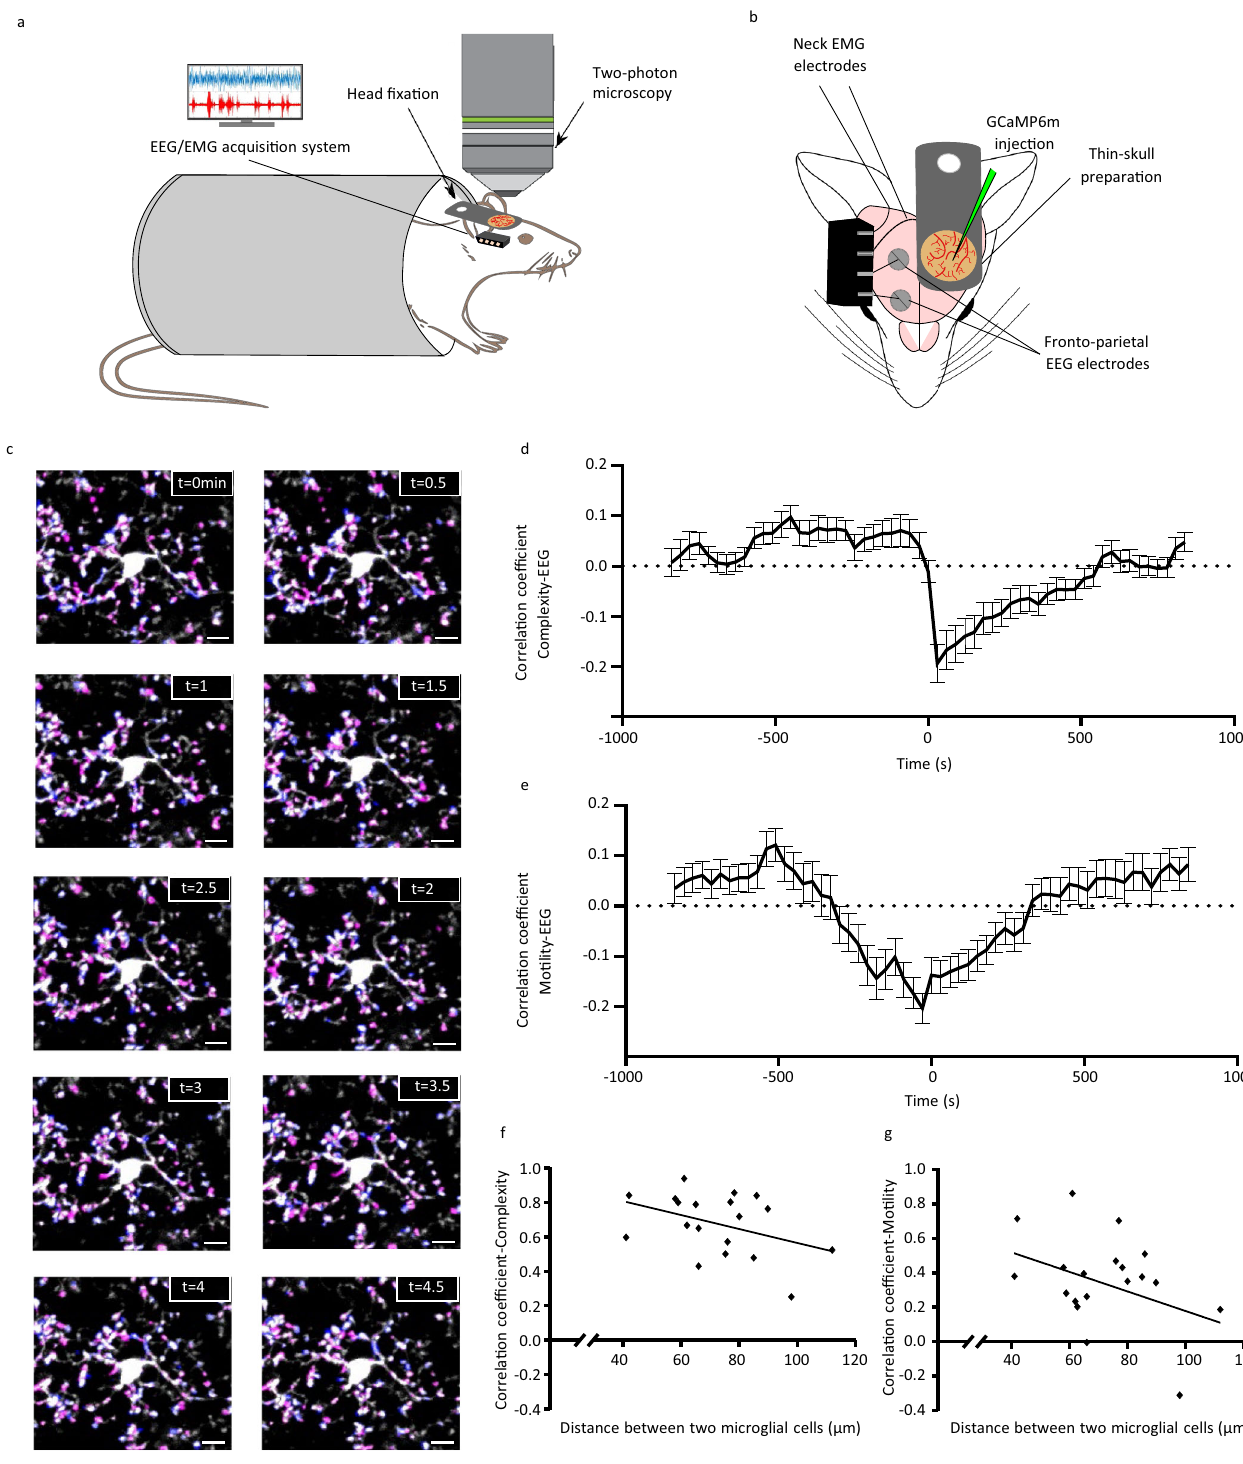
Fig. 1 | Neuronal activity correlates with microglial complexity and motility. a, b Schematic representation of our experimental setup. a Head-restrained mice were trained for simultaneous two-photon imaging with electrophysiology (side view). b Fronto-parietal EEG and neck EMG electrodes were implanted, combined with a thinned-skull cortical window preparation and calcium indicator injection (top view). c Example of microglial motility over a 5-min period, showing micro- glial process retractions in magenta, and process extensions in cyan. Scale bar=